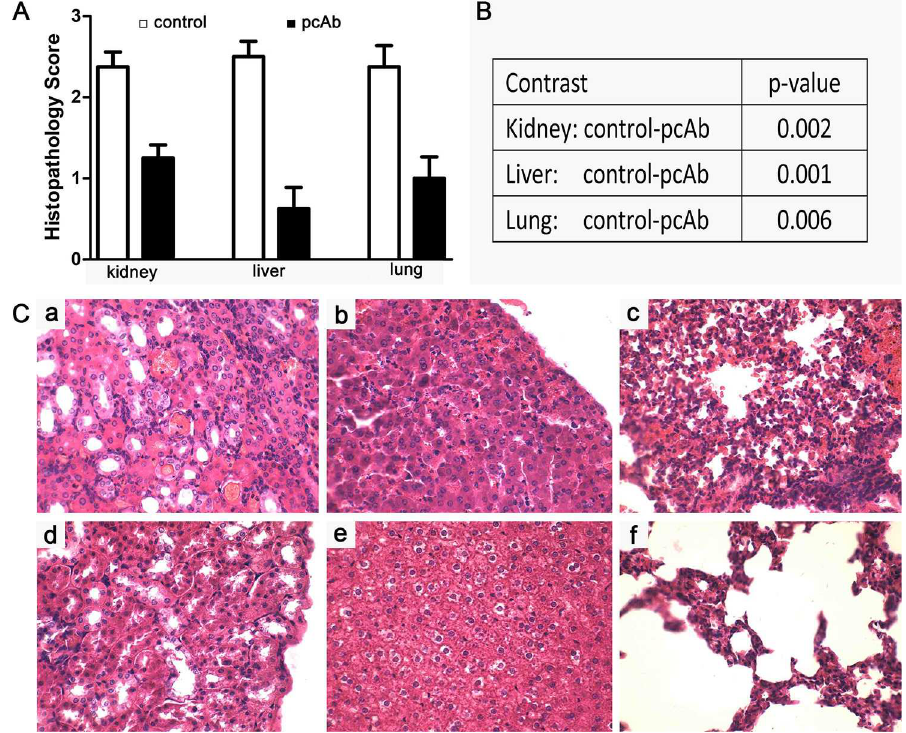
Fig 4. Histopathology and scores of kidney, liver and lung after infection with Leptospira interrogans serogroup Lai (56601)or Autumnalis (56606). (A) Histopathology scores of the kidney, liver and lung in hamsters. The data representthe mean histopathology scores for the two groupsof hamsters. Statistical analysisof results for infected controls (n = 8) and pcAb group (n = 8) was performed using the Wilcoxon rank sum test. * p < 0.05. (B) Tukey-Kramer pair-wise comparisons with the control. (C) Histopathology of the kidney (a, d), liver (b, d), and lung (c, f) of infected controls (a, b, c) and the pcAb group (d, e, f) after infection with leptospirain hamsters. These representative photographs were selectedfrom hamsters infected 56601 or